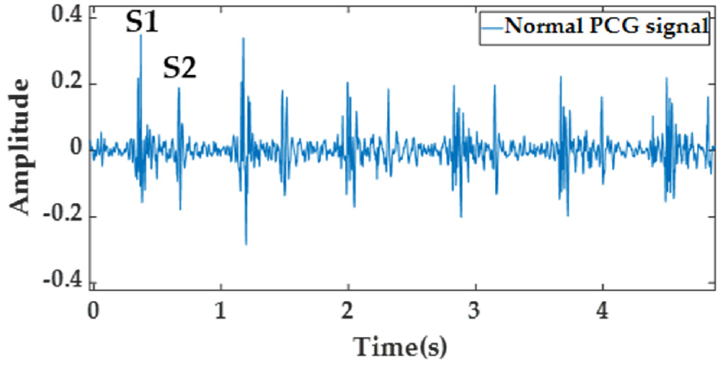
Figure 1. Normal PCG